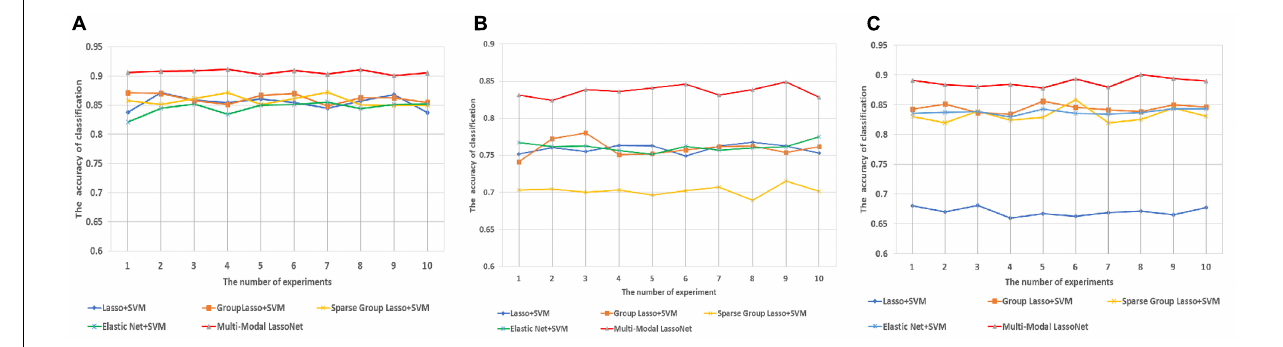
FIGURE 3 | The prediction accuracy was obtained through 10 experiments for five methods in three groups. (A) Prediction accuracy of AD-HC group. (B) Prediction accuracy of AD-EMCI group. (C) Prediction accuracy of EMCI-HC group. TABLE 3 | The classification performance comparison of the five methods.